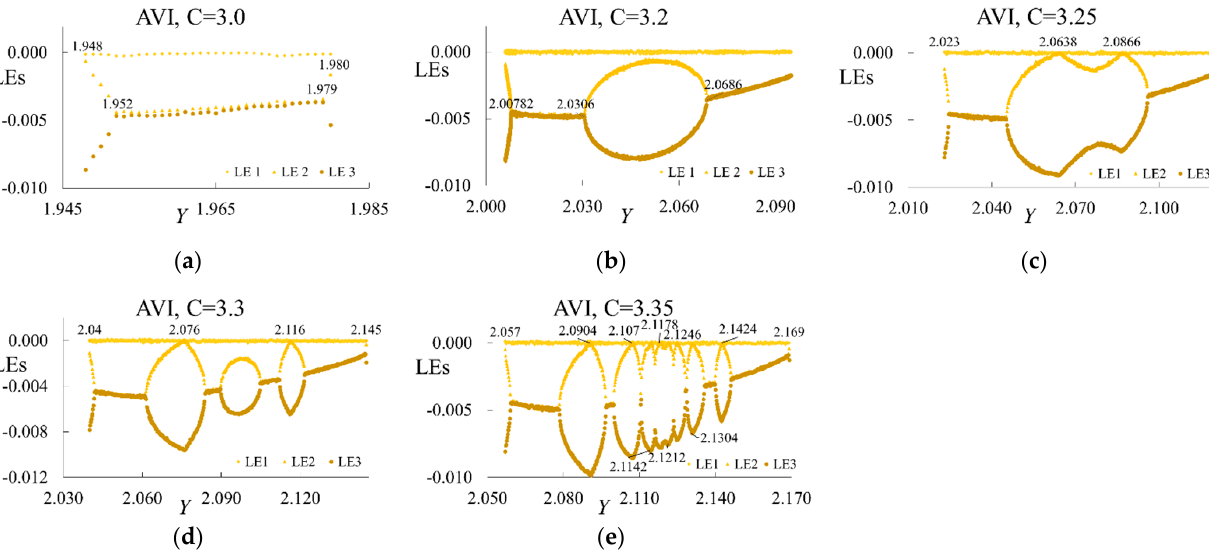
Figure 6. Schematic of LEs vs Y graphed over the domains of AVI at different values of the gain, C . ( a – e ) C = 3.0 , 3.2 , 3.25 , 3.3 , and 3.35, respectively.